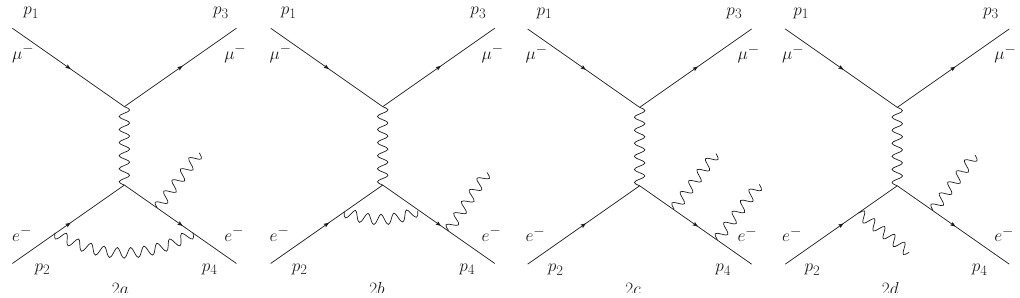
Figure 2 . Sample diagrams for the one-loop QED corrections to single photon emission (diagrams 2a-2b); sample diagrams for the double bremsstrahlung process (diagrams